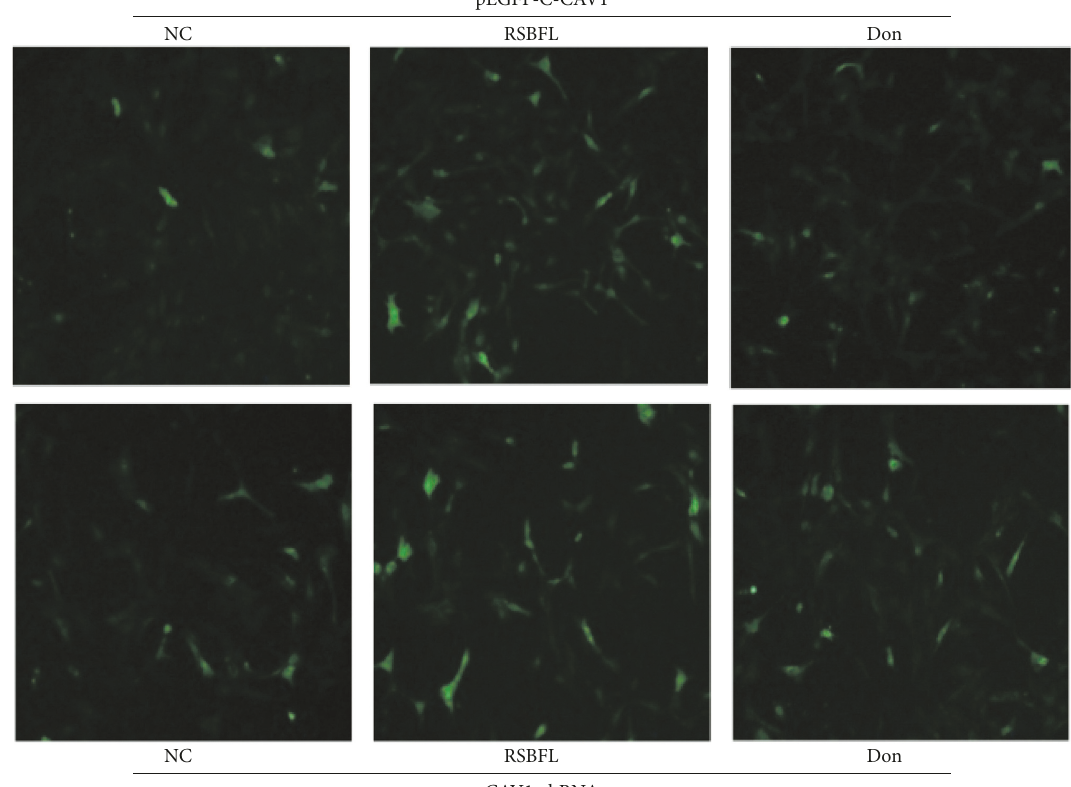
Figure 4: The pEGFP-C1-CAV1 expression in hippocampal neurons subjected to the treatments with sera containing RSBFL and donepezil in the presence and absence of